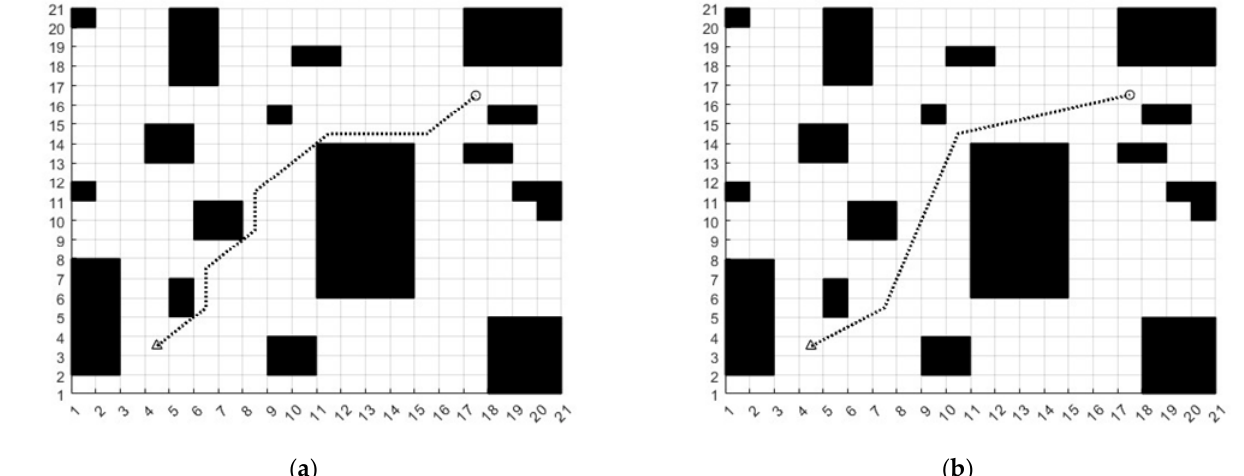
Figure 7. ( a ) Traditional A* path, ( b ) Secondary de-redundant path. In order to verify the e ff ectiveness of the B spline curve, set the starting coordinates to (4, 3) and the ending coordinates to (17, 16). Then, an unsmoothed path and a smoothed